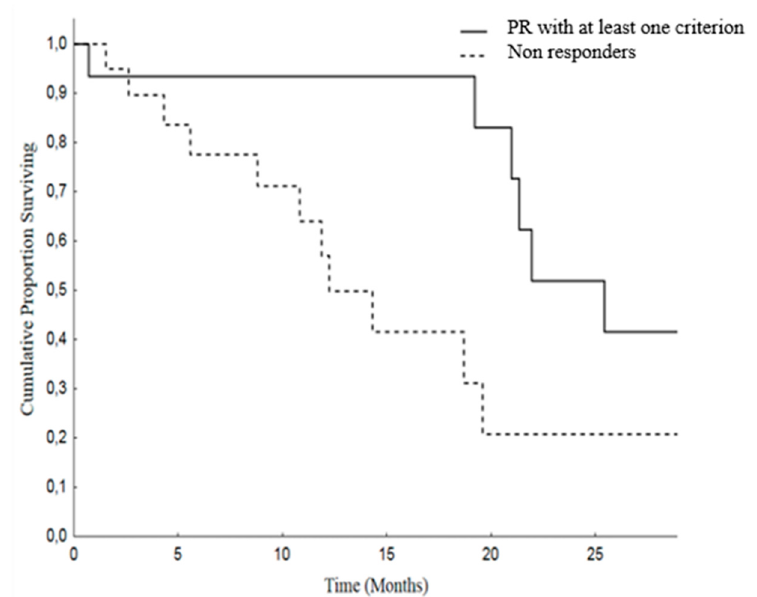
Figure 2. Overall Survival (OS) in patients with PR with at least one criterion [median 25.4 months (19.3–31.4)] versus no response disease [median 12.2 months (8.2–16.2)], p = 0.019.